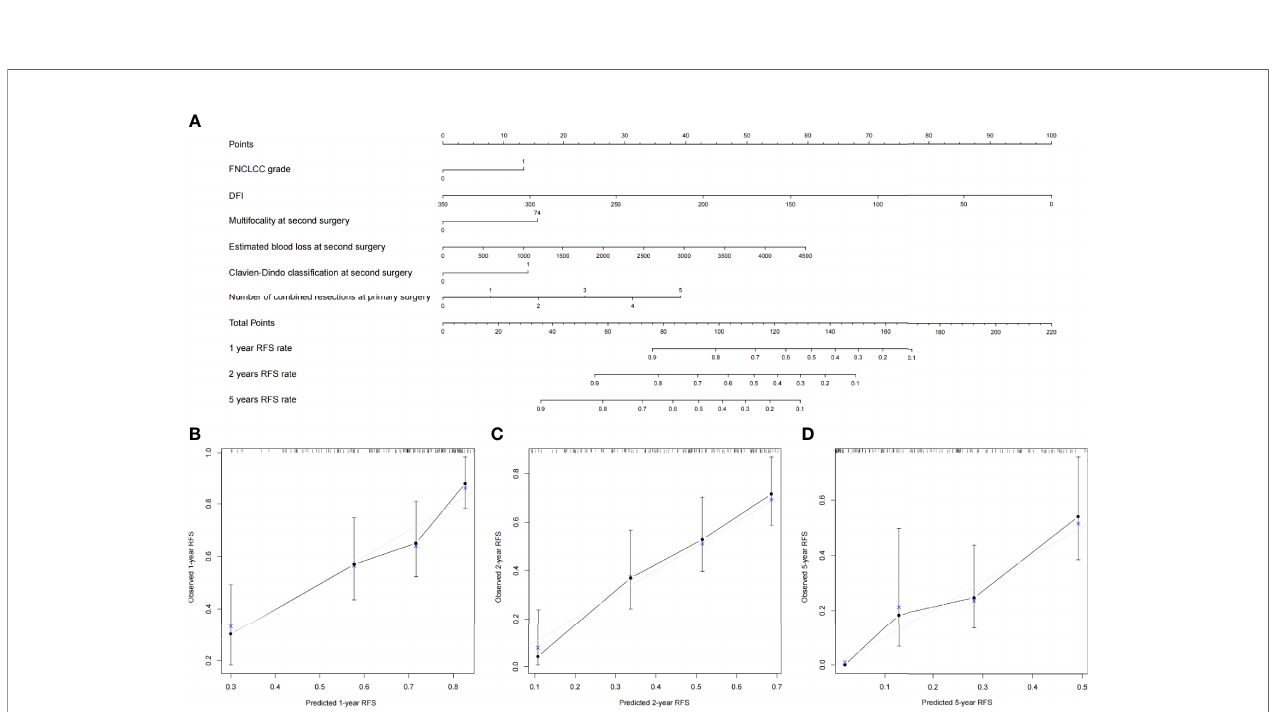
FIGURE 4 | (A) Nomogram for 1-, 2-, and 5-year recurrence-free survival in patients with fi rst local recurrent retroperitoneal sarcoma and calibration plots for internal validation of (B) 1-, (C) 2-, and (D) 5-year recurrence-free survival